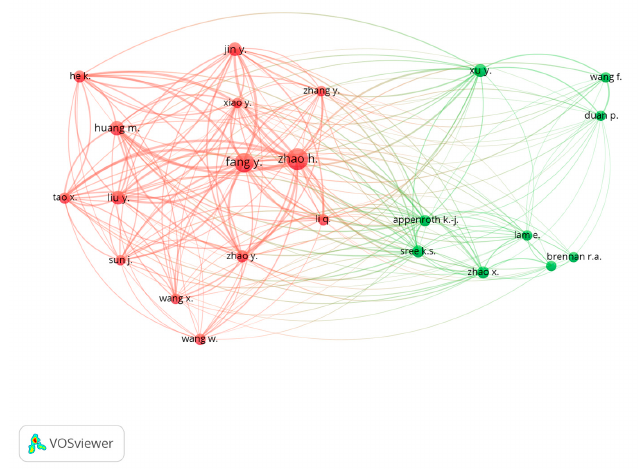
Figure 8. Co-citations of the authors.